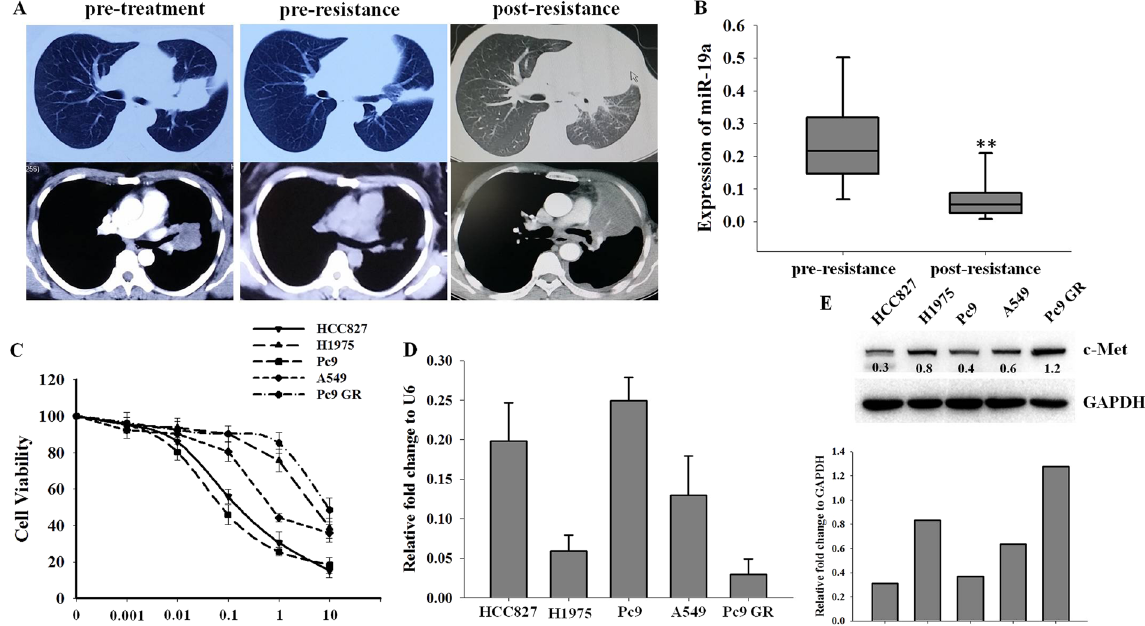
Figure 1. miR-19a expression in NSCLC patient serum samples and cell lines ( A ). Patients were treated with gefitinib and examined monthly with Computerized Tomographic Scanning (CT). Patients were sensitive to gefitinib at the initial stage and became resistant to gefitinib, which was detected by CT; ( B ) The expression of miR-19a was detected in patient serum samples. Serum was obtained from fifteen patients prior to oral gefitinib treatment (pre-resistance) and after they had developed gefitinib resistance (post-resistance). Total RNA was extracted from the serum using the miRNeasy mini kit (QIAGEN), and the miR-19a level was measured